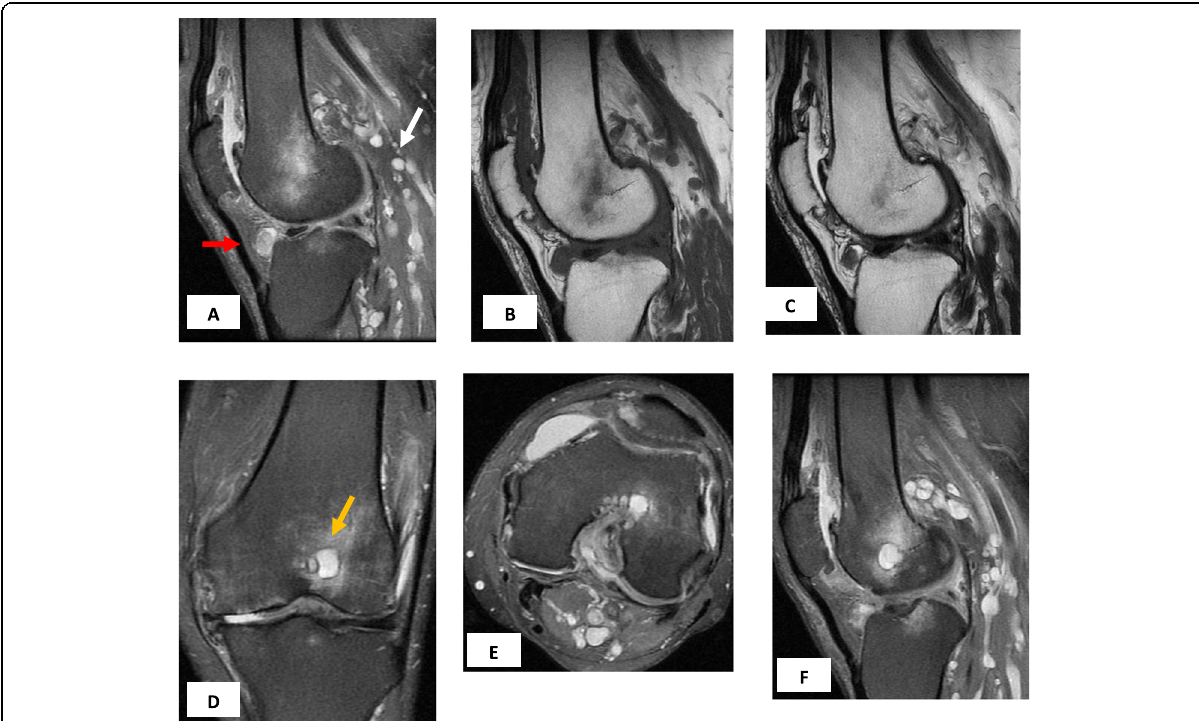
Fig. 9 Right knee synovial ganglion cyst at Hofa ’ s fat in 61-year-old male. Sagittal STIR ( a , f ), sagittal T1 ( b ), sagittal T2 ( c ), coronal STIR ( d ), and axial STIR ( e ) show marked osteoarthritis, lower femur cyst (Geod, yellow arrow), popliteal varicose veins (white arrow), and synovial ganglion cyst (red arrow) displaying low signal at T1 and T2, mixed low and high at STIR